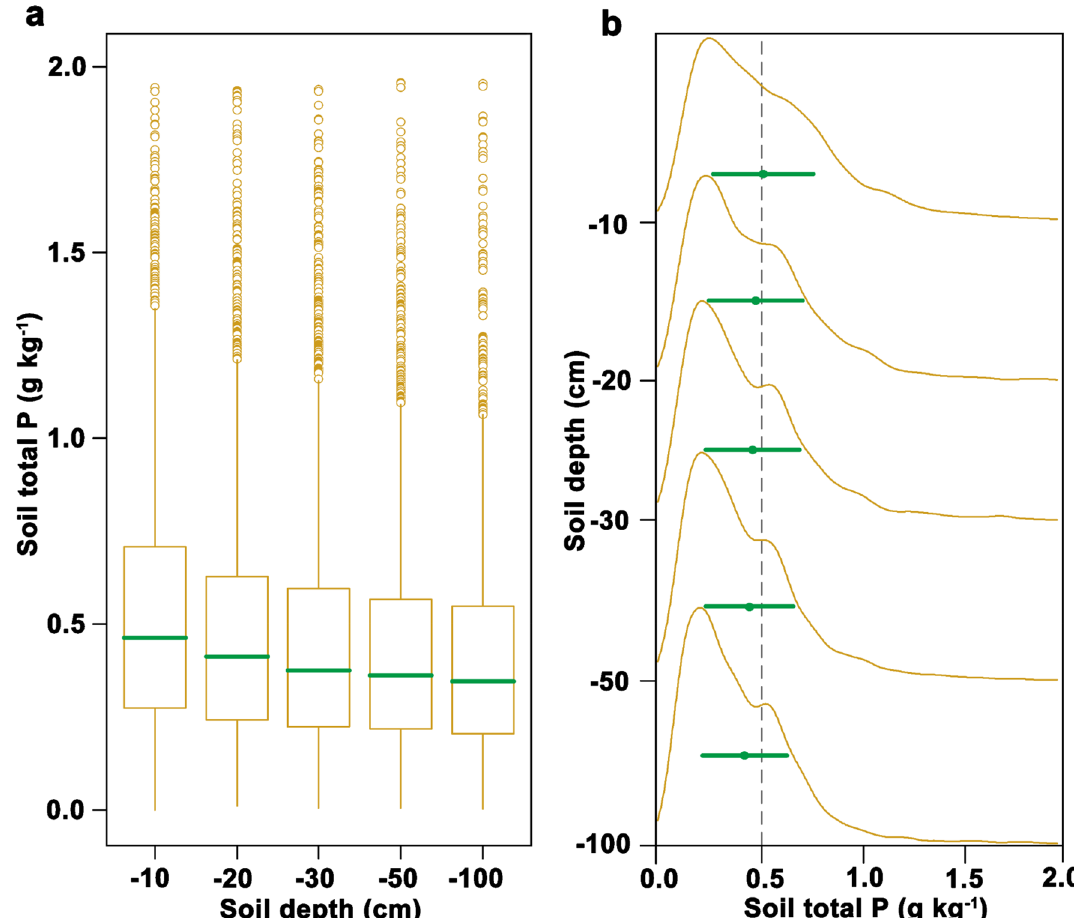
Figure 2. Comparisons of soil total P in terms of its vertical distribution characteristics. ( a ) Soil total P with increasing soil depth. The lines across the boxes indicate the median values, and the lower and upper boxes shows the interquartile range (25th and 75th percentiles, respectively). ( b ) Density distribution of soil total P concentration in the different soil layers. The values of points and error bars indicate means ± SD for the different soil layers. − 10, − 20, − 30, − 50, and − 100 represents the 0–10 cm, 10–20 cm, 20–30 cm, 30–50 cm, and 50–100 cm soil depths,